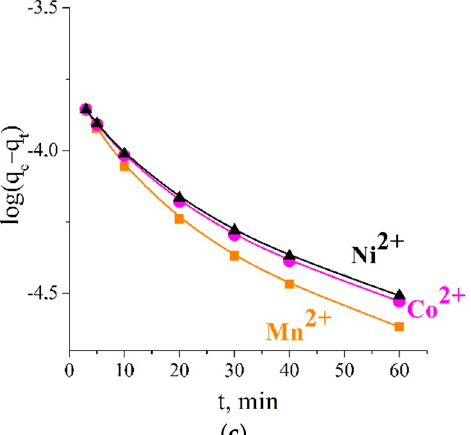
Figure 7. Pseudo-first-order kinetics plot for studied ions’ adsorption on titanium phosphate at 298 K ( a , b ) and 303 K ( c ). The kinetic experimental data obtained for the sorption from multicomponent solution also did not correspond to the pseudo-first order model, but the experimental data were fitted well to the pseudo-second-order reaction model. The plots of t/q t versus t were straight lines, and the regression coefficients R 2 were close to 1 for all the studied ions. The obtained calculated values of q e coincided with the values of q exp (Figure 8).